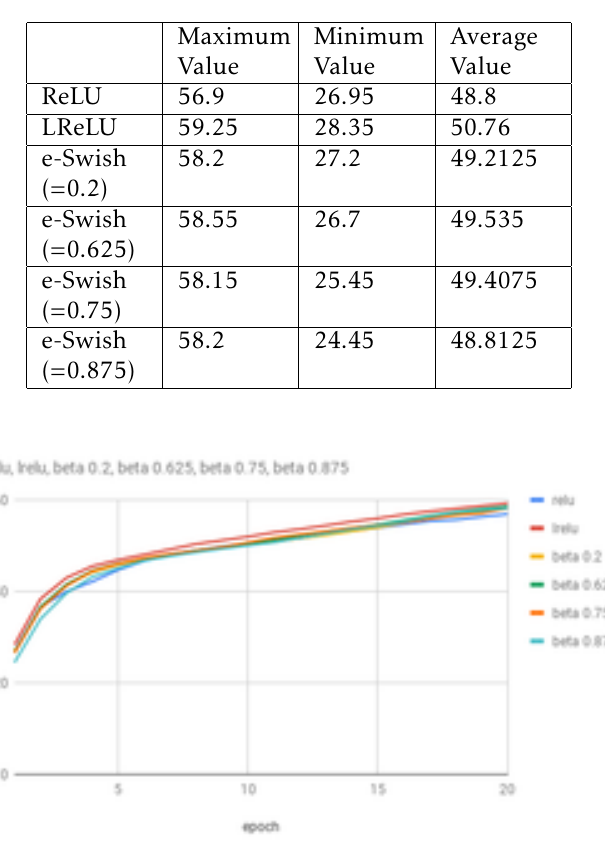
Figure 2. Visualisation of activation function optimisation of Capsnets on CIFAR-10 dataset in terms of Accuracy Table 2. Optimisations and Regularisations of Capsnets on CIFAR-10 dataset